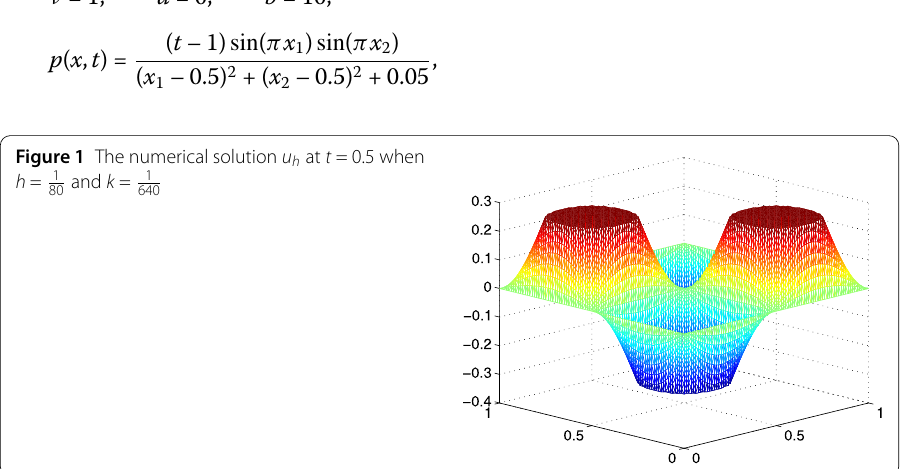
Figure 1 The numerical solution u h at t = 0.5 when and k = 1 h = 1 80